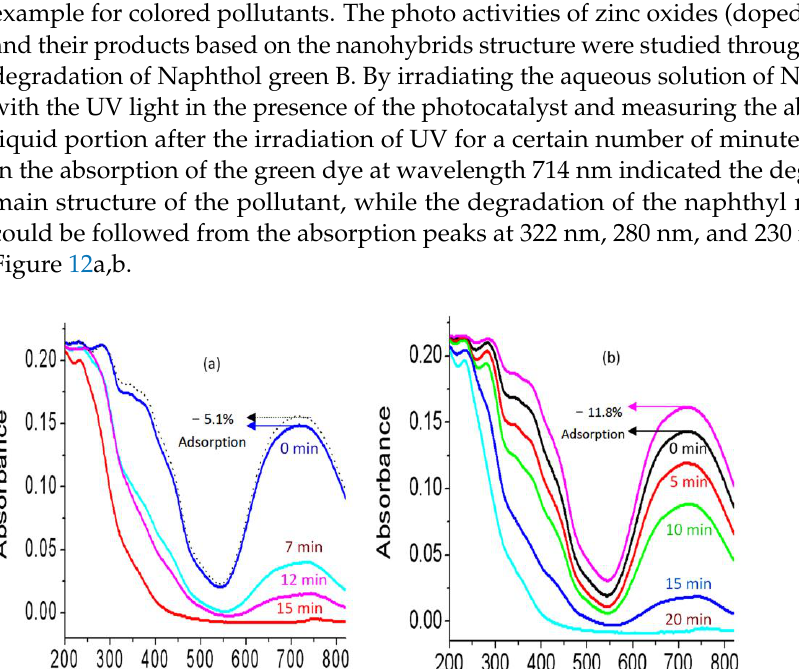
light irradiation time in the presence of the photocatalyst as seen in Figure 12. When the aqueous solution of Naphthol green B was mixed with the photocatalyst for 10 min in the dark, an appropriate change was observed indicating that these photocatalysts have ad- sorption power. By calculating the removal percentage of the green dyes through the adsorption process, Figure 12a shows that the sample NHZ-1-500 removed 5.1%. In the case of the sample ZNH-2-500, 11.8% was removed by the adsorption process. Therefore,